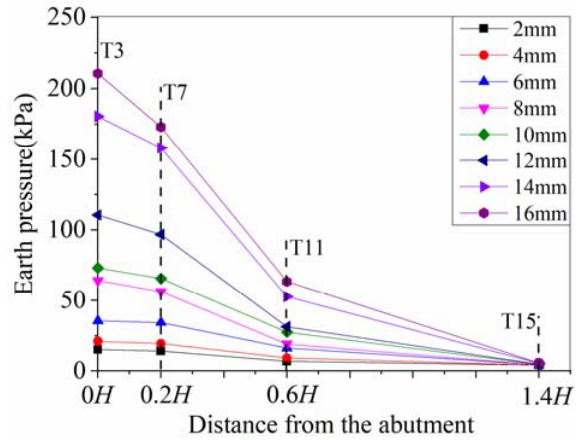
Figure 12. Distribution of earth pressure along the longitudinal direction.